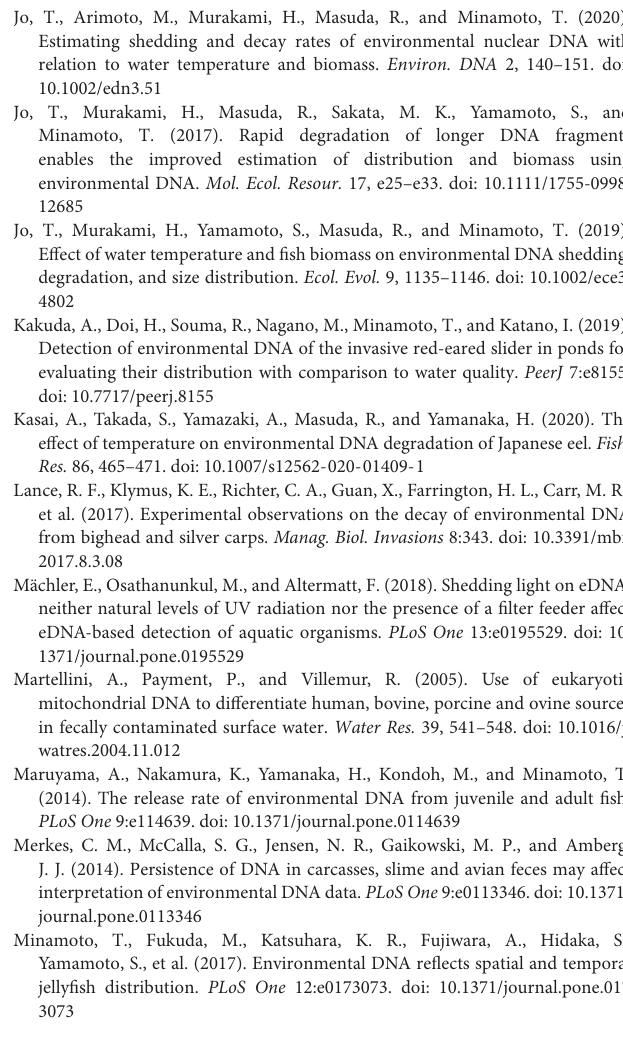
rate in each experiment. The boxes and bars in the box plot indicate median ± inter-quartiles and ± 1.5 × inter-quartiles, respectively. Supplementary Figure 2 | The eDNA degradation rate (simple exponential slope) with (A) DNA region and (B) water source. In the plot, the limited data were excluded; NADH, D-loop, ND2, and ND4 for PCR region and pond, well for water source. The dots indicate the individual eDNA degradation rate in each experiment in different ecosystems. The boxes and bars in the box plot indicate median ± inter-quartiles and ± 1.5 × inter-quartiles, respectively. Supplementary Figure 3 | The eDNA degradation rate (simple exponential slope) with temperature category. The temperature categories are divided into four levels: − 1, 0–10, 11–20, and > 21 ◦ C. The dots indicate the individual eDNA degradation rate in each experiment in different ecosystems. The boxes and bars in the box plot indicate median ± inter-quartiles and ± 1.5 × inter-quartiles, respectively. Supplementary Figure 4 | The eDNA degradation rate (simple exponential slope) with amplicon length category. The amplicon length categories are divided into three levels: 0–100, 101–200, and > 201. The dots indicate the individual eDNA degradation rate in each experiment in different ecosystems. The boxes and bars in the box plot indicate median ± inter-quartiles and ± 1.5 × inter-quartiles, respectively. Supplementary Table 1 | All data analyzed in this